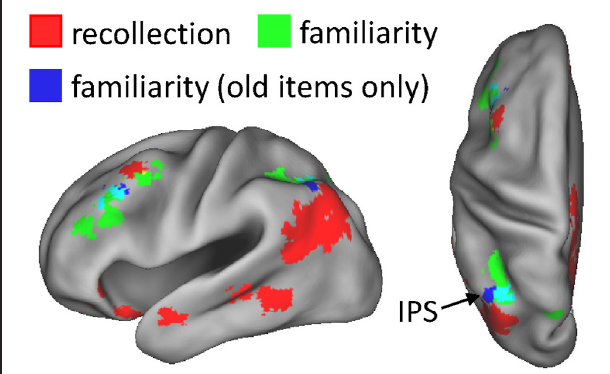
FIGURE 3 | Regions exhibiting familiarity effects based solely on old test items (blue), shown alongside the neural correlates of recollection (red) and familiarity (green). Old-item familiarity effects were evident in left intraparietal sulcus (IPS; 56 voxels; peak coordinates = − 40, − 61, 49; peak Z score = 3.40) and left middle frontal gyrus (60 voxels; peak coordinates = − 40, 32, 32; peak Z score = 3.62). The arrow points to overlap (constituting 20 voxels; in cyan) of the familiarity effects in